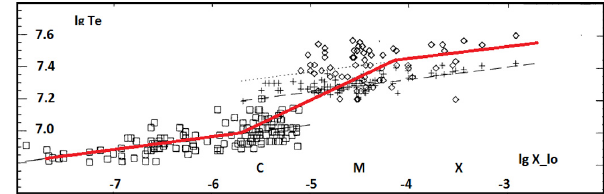
Fig. 2. Flare electron temperature vs. X-ray intensity (0.1–0.8nm); adapted from Yuda et al. (1997), squares: S XV, crosses: Fe XXV, diamonds: Fe XXVI; red line: our fit.